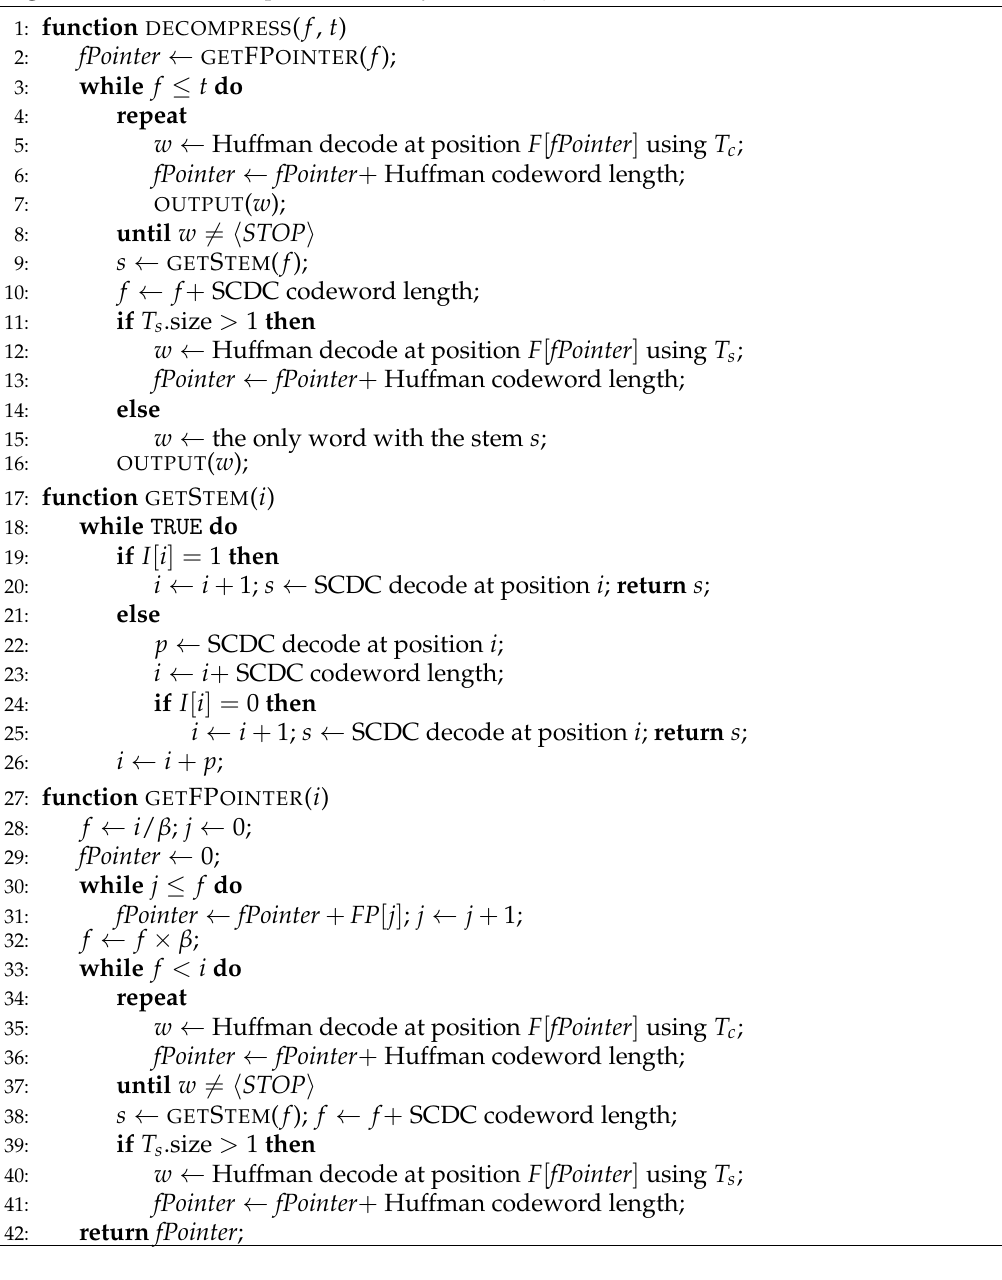
Algorithm 1 PISI Decompression from Byte Position